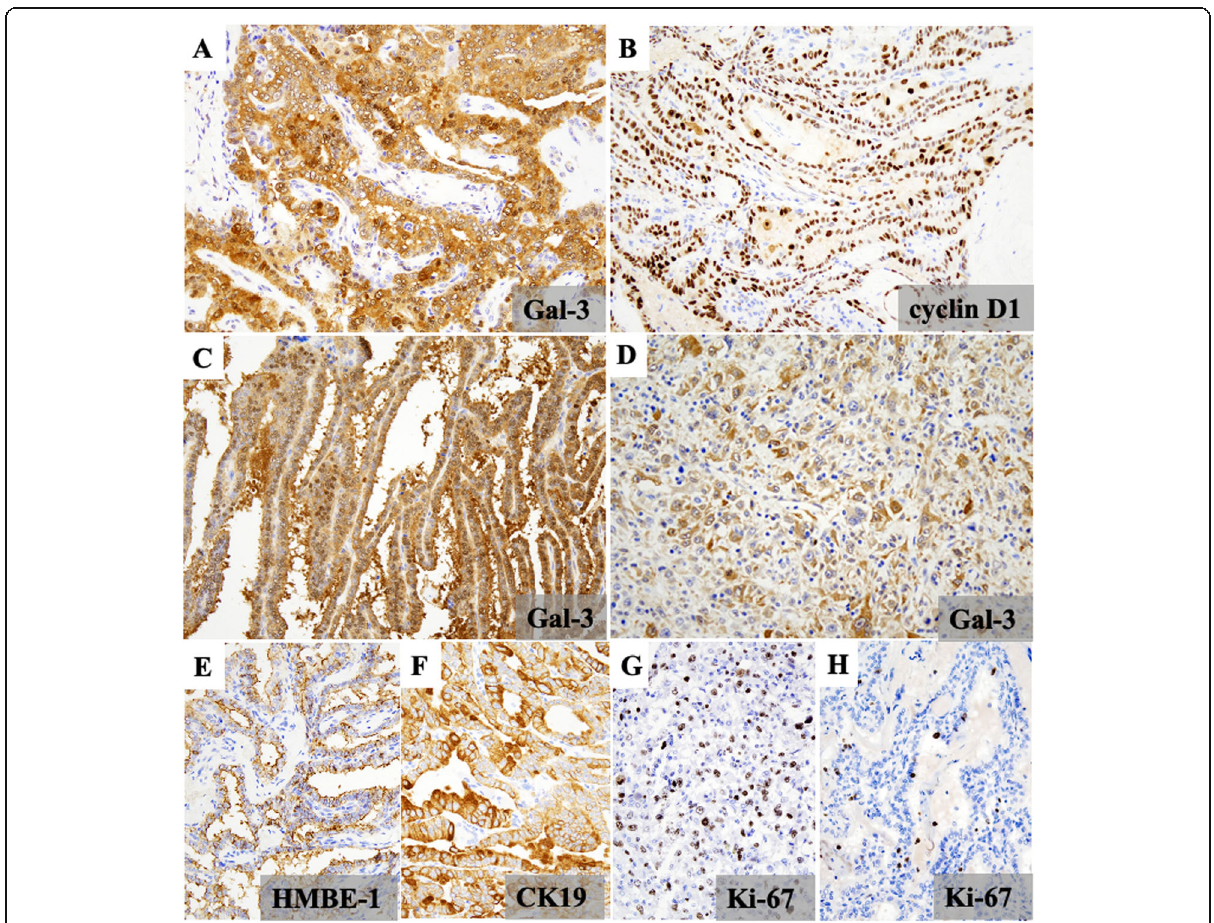
Fig. 3 Immunohistochemical staining results for other thyroid tumor markers. In microcarcinoma, cancer cells exhibited strong positivity for galectin-3 (Gal-3) ( A ) and nuclear positivity for cyclin D1 ( B ). In papillary carcinoma, the cytoplasm of cancer cells was diffusely positive for Gal-3 ( C ). Undifferentiated carcinoma showed cytoplasmic immunopositivity for Gal-3 with a mosaic-like pattern ( D ). In papillary carcinoma, the luminal side of papillary structures was positive for Hector Battifora mesothelial 1 (HBME-1) ( E ), and tumor cells were diffusely positive for cytokeratin 19 ( F ). In undifferentiated carcinoma, cancer cells were diffusely positive for Ki-67 ( G ), whereas tumor cells in papillary carcinoma were sporadically positive for Ki-67 ( H